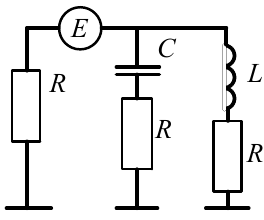
Fig. 2. Equivalent schematic of the feeding